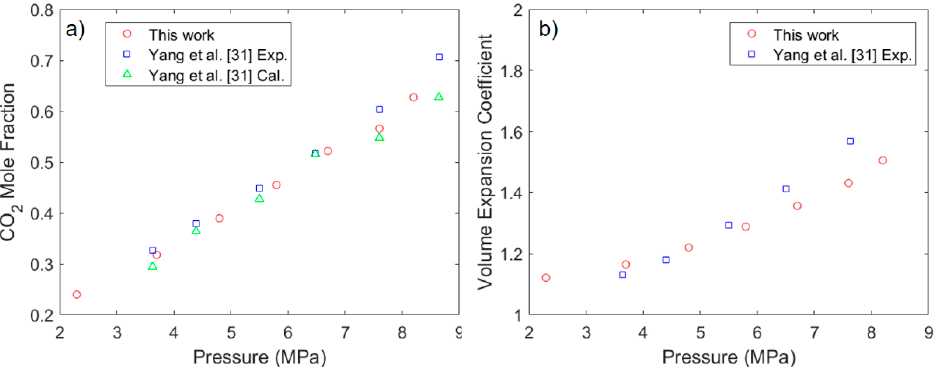
Figure 4. ( a ) CO 2 mole fraction in n -octane as a function of the pressure at 343.15 K. ( b ) Volume expansion coefficient of liquid phase as a function of pressure. Blue square is the experimental data and green triangle is the prediction by equation of state from Yang et al. [31].